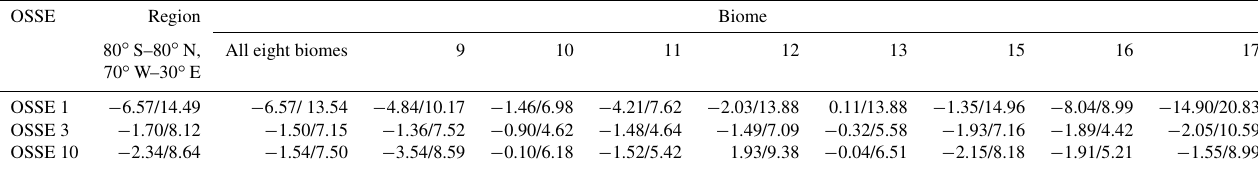
Table 5. Differences (Eq. 4) between OSSE FFNN outputs and NEMO/PISCES p CO 2 and its standard deviation (SD) (Eq. 5) (in µatm). OSSE Region